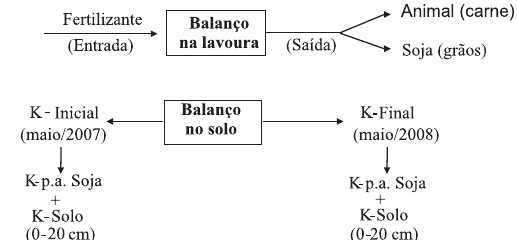
Figura 2. Balanço “na lavoura” e “no solo”, com seus componentes considerados neste estudo em sistema de integração lavoura-pecuária. p.a.: parte aérea da